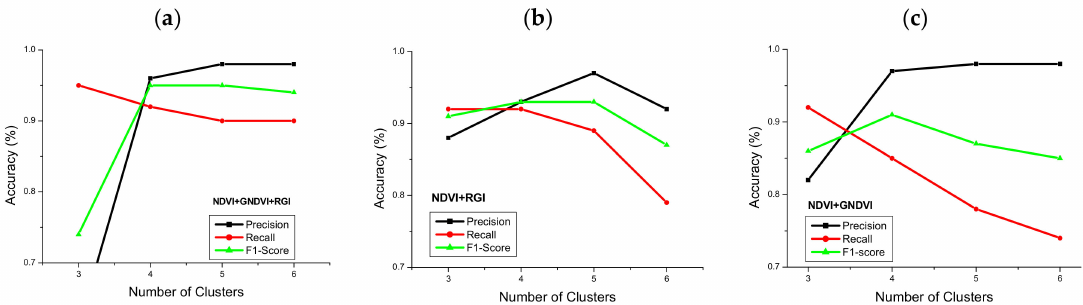
Figure 6. Classification accuracy as a function of the number of clusters used in the k-means classification for the three-band combinations: ( a ) ∆ NDVI, ∆ RGI, ∆ GNDVI, ( b ) ∆ NDVI, ∆ RGI and ( c ) ∆ NDVI, ∆ GNDVI.